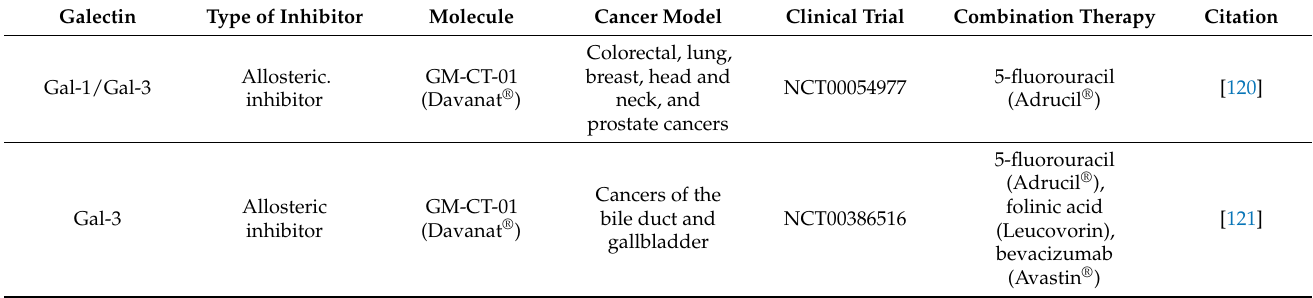
Table 1. Targeting Gal-1, -3, and -9–ligand axis in combination therapies currently in clinical